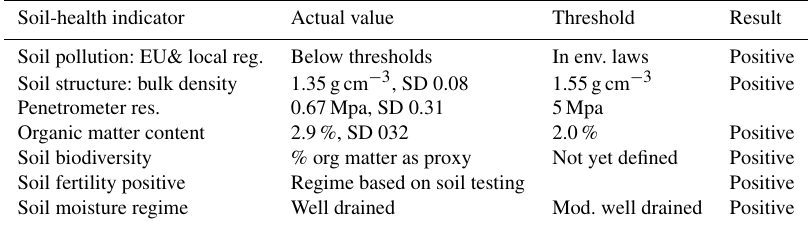
Table 2. Soil health indicators for the living lab described in Table 1. Conclusion: this soil is healthy and offers a positive entry point for SDG 15 in terms of lack of soil